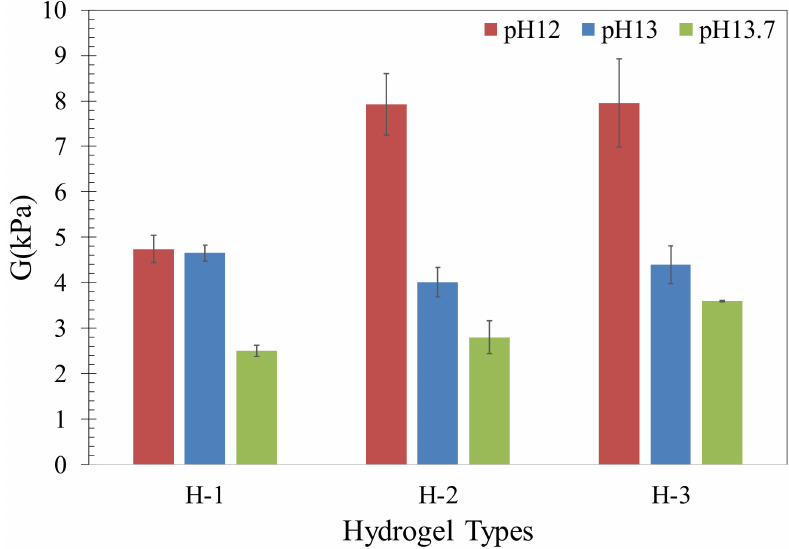
Figure 3. Shear modulus of hydrogels swollen in the synthetic pore